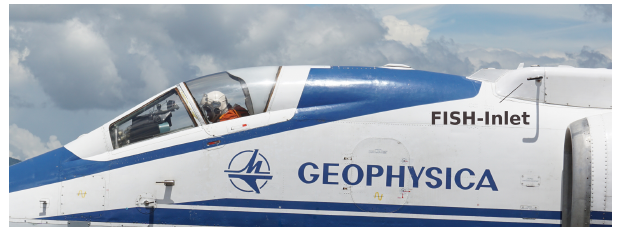
Figure 5. Side-mounted FISH inlet at Geophysica (photo: Armin Afchine).